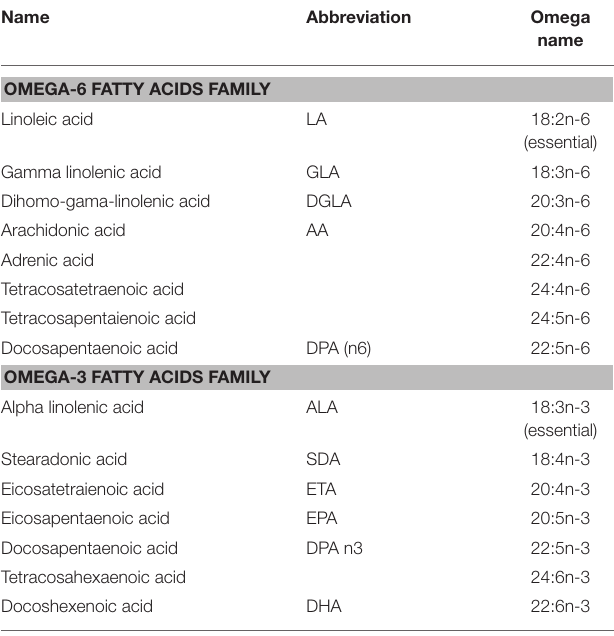
TABLE 1 | Omega fatty